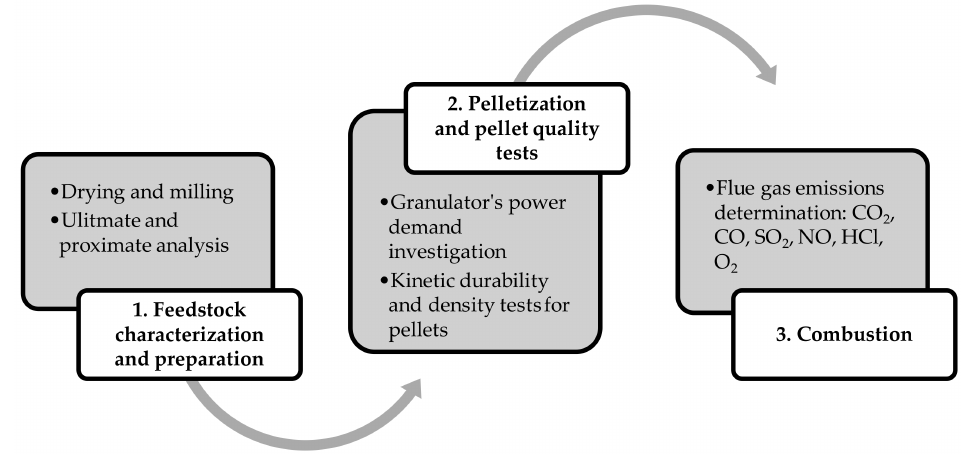
Figure 1. Scheme of the research.